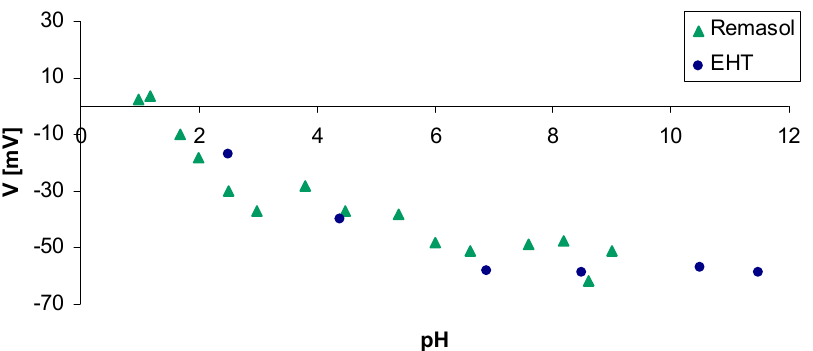
Figure 13. Dependence of zeta potential on pH for Remasol and EHT binders used to produce structural layers of a ceramic casting mould.